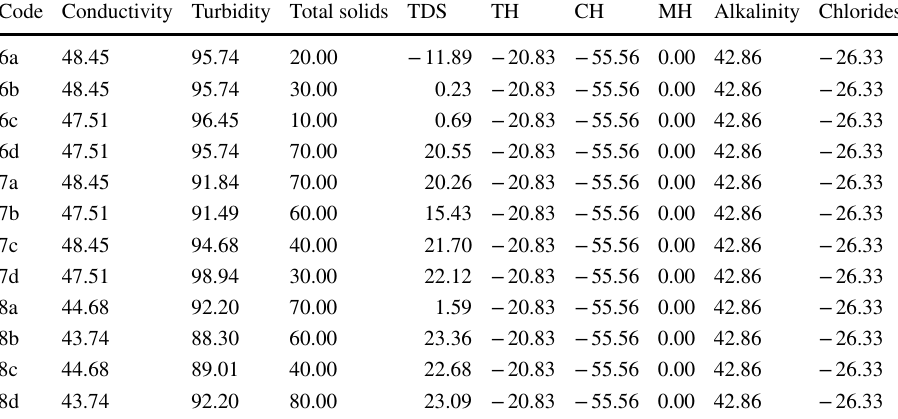
TDS total dissolved solids, TH total hardness, MH magnesium